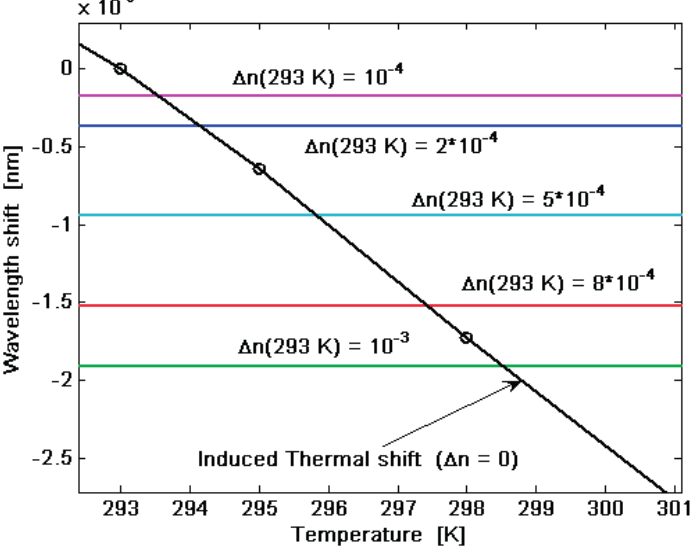
Figure 10. Wavelength shift versus temperature. Horizontal lines: wavelength shift for different values of cover refractive index